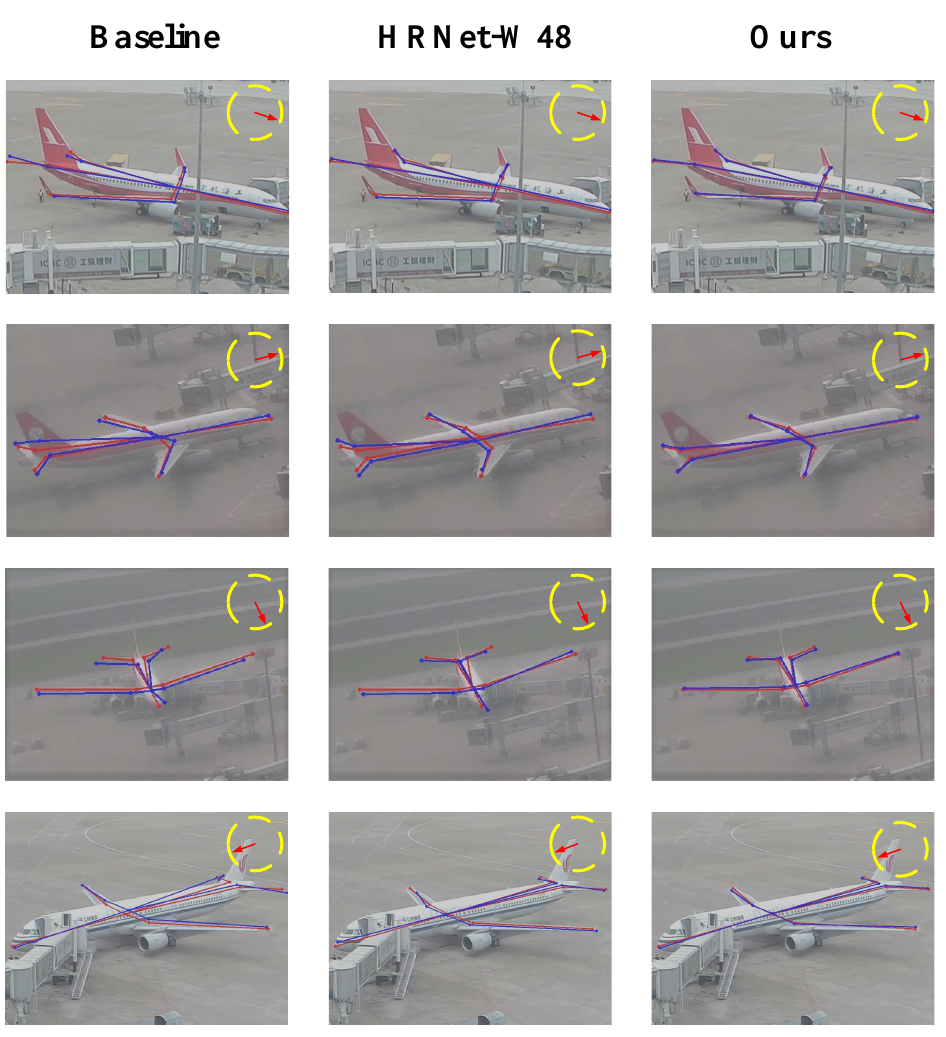
Figure 9. The results (blue) of the aircraft pose visualization and ground truth skeleton (red) for a better view of the aircraft skeleton. Table 2. Effect of different super-resolution subnetworks on aircraft pose